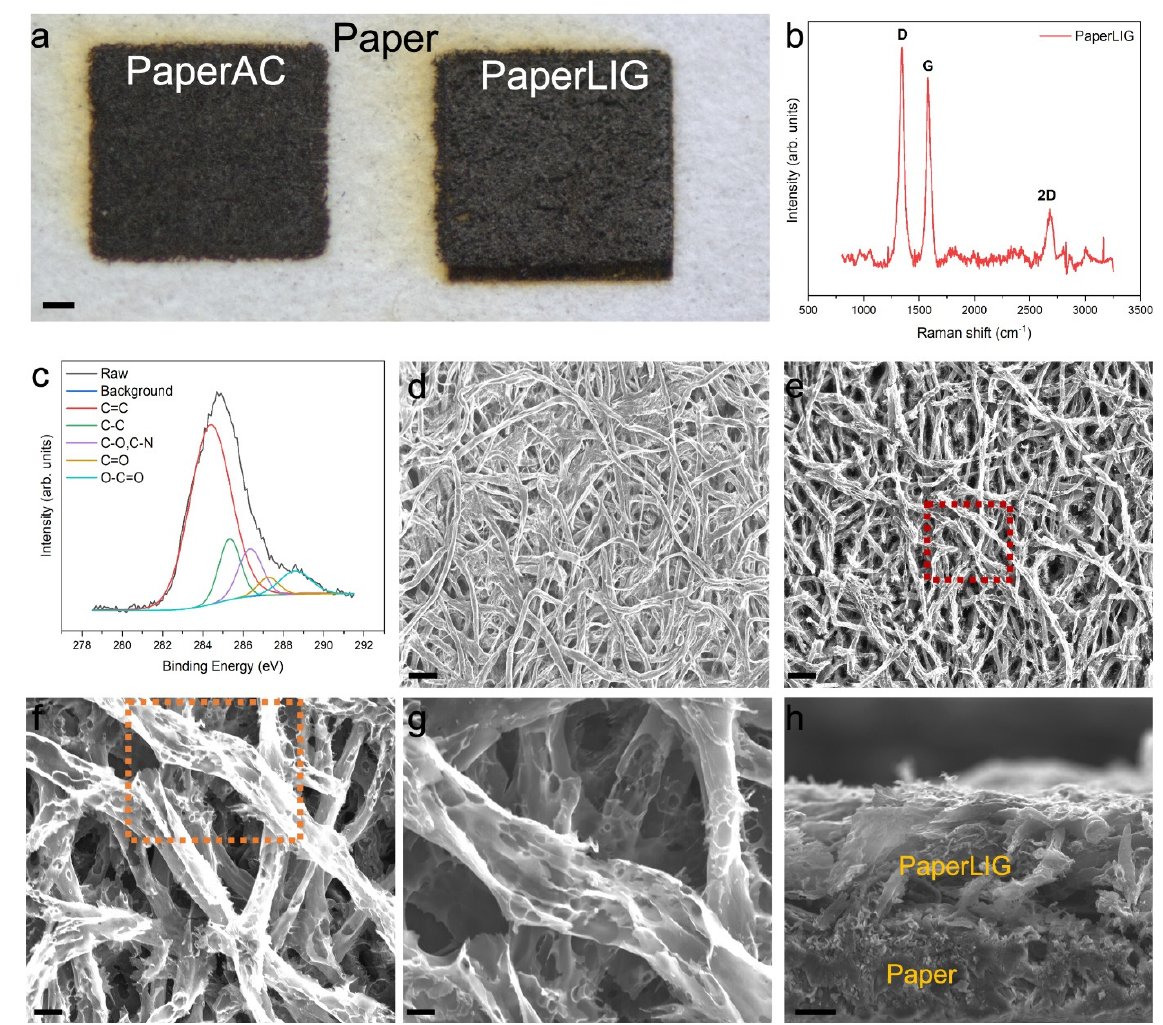
Figure 2. ( a ). The optical image of fabricated PaperAC and PaperLIG. Scale: 1 mm. ( b ) Raman spec-trum of PaperLIG material. Three prominent peaks are found in the Raman spectrums. ( c ) The high-resolution C1s XPS spectrum of PaperLIG. The raw curve was fitted with peaks corresponding to five carbon species. ( d , e ) SEM images of filter paper and PaperLIG. Scale: 100 µm. ( f ). A magnified SEM image of the red rectangular part of Figure 2e. Scale: 20 µm. ( g ) A magnified SEM image of the orange rectangular part of Figure 2f. Scale: 10 µm. ( h ) A cross-sectional SEM image of PaperLIG. Scale: 33.3 µm.